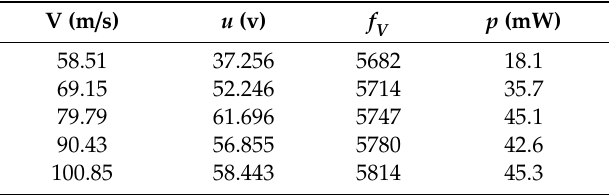
Table 4. Output test data for the